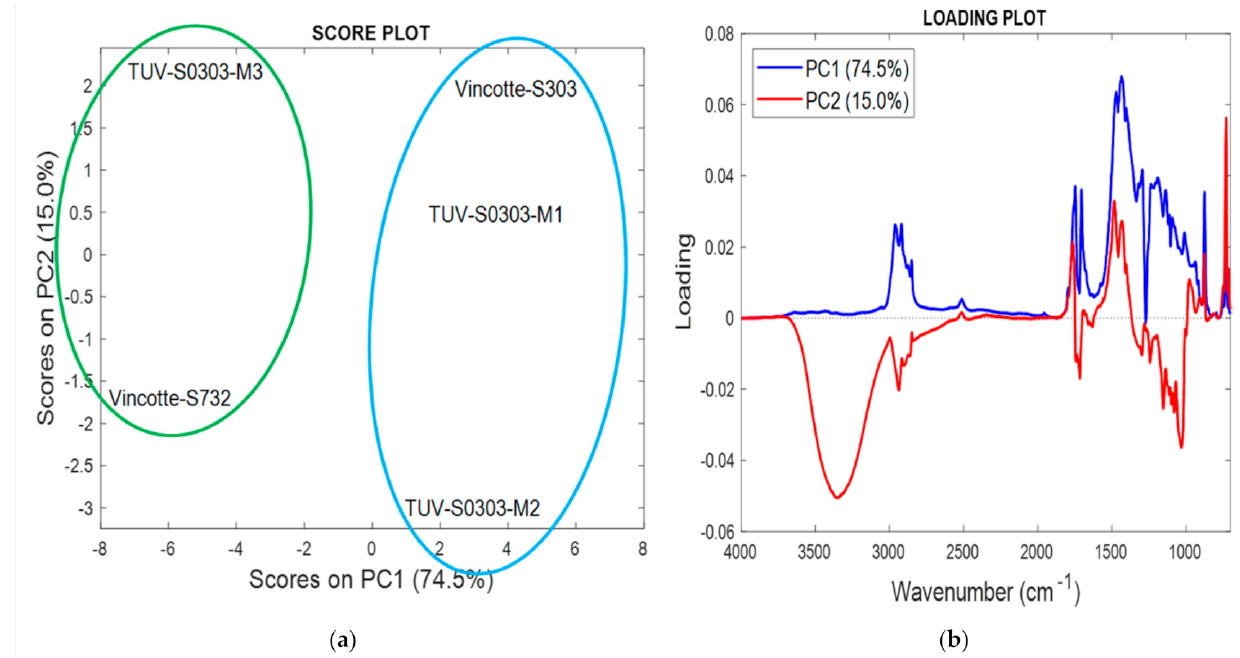
Figure 8. Results of PCA represented as score plot ( a ) and loading plot ( b ) performed on the small matrix collecting spectral data of five samples, by using R software.